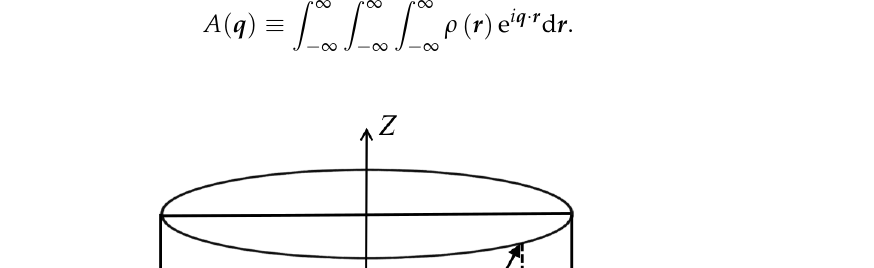
(cid:0) (cid:1) q x , q y , q z and